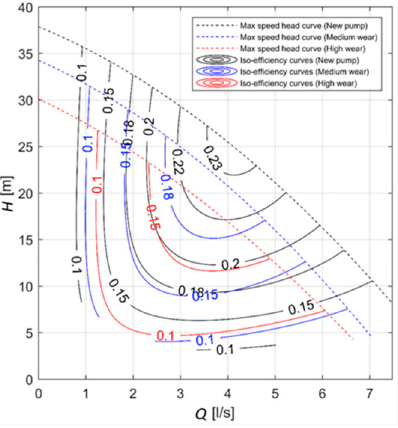
Water 2020 , 12 , x FOR PEER REVIEW Figure 16. Comparison of characteristic and efficiency curves for different stages of wear [23]. Figure 16. Comparison of characteristic and e ffi ciency curves for di ff erent stages of wear [23].